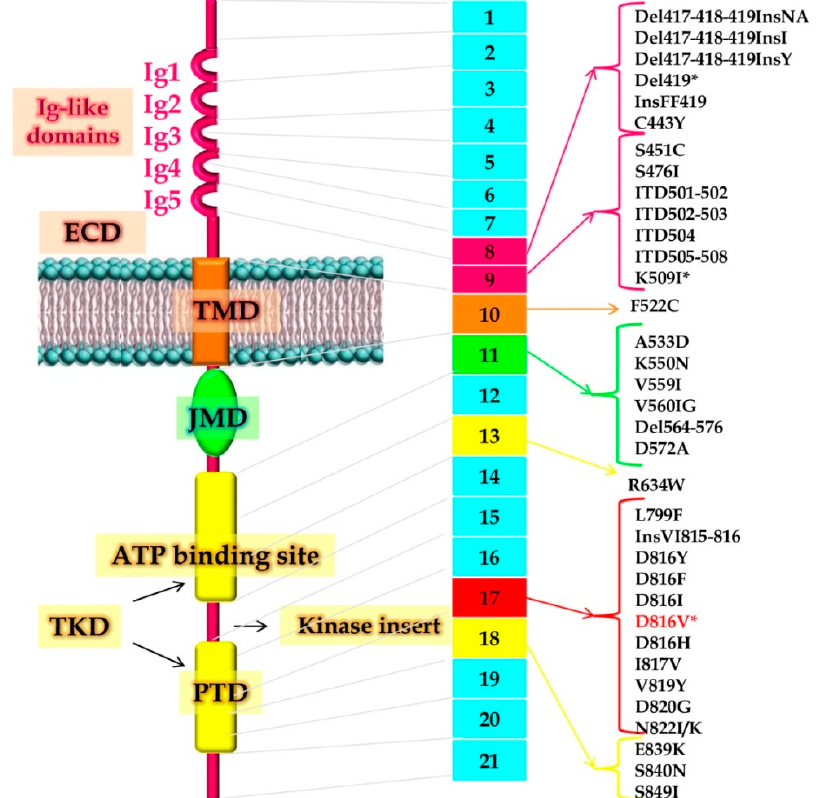
Figure 1. Representation of the structure of the KIT receptor, illustrating the known function of its domains and localization of all reported KIT mutations in adult patients with mastocytosis. On the left is shown the structure of the receptor. In the center, the 21 KIT exons and the most frequently identified mutations are reported. Abbreviations: Del, deletion; ECD, extracellular domain; Ins, insertion; ITD, internal tandem duplication; JMD, juxtamembrane domain; TKD, tyrosine kinase domain; PTD, phosphotransferase domain; TMD, transmembrane domain. *: mutation found in around 30% of pediatric patients and in > 80% of all adult patients.